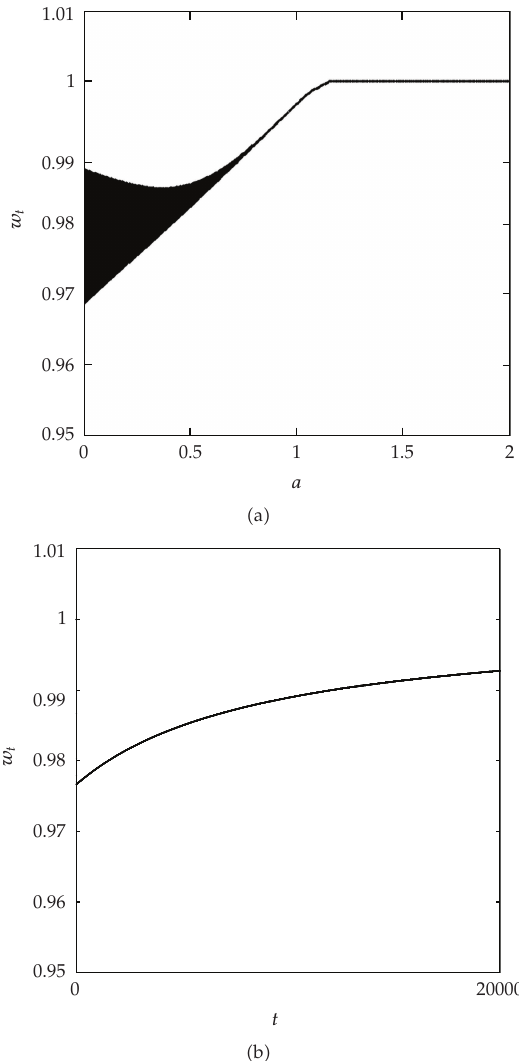
Figure 2: (cid:2) a (cid:3) Diagram of the state variable w t with respect to a for the initial condition x 0 ≥ 1, m 0 (cid:9) − 1 and w 0 (cid:9) 1 and parameter values α (cid:9) 0 . 5, λ (cid:9) 1, σ 2 (cid:9) 1, r (cid:9) 0 . 02, C (cid:9) 0 . 5. We ignore the first 1000 iterations and we plot the following 5000 values of w t for each value of a . (cid:2) b (cid:3) Trajectory of the state variable w t versus time. We consider a (cid:9) 0 . 3 and we plot the first 20000 iterations.